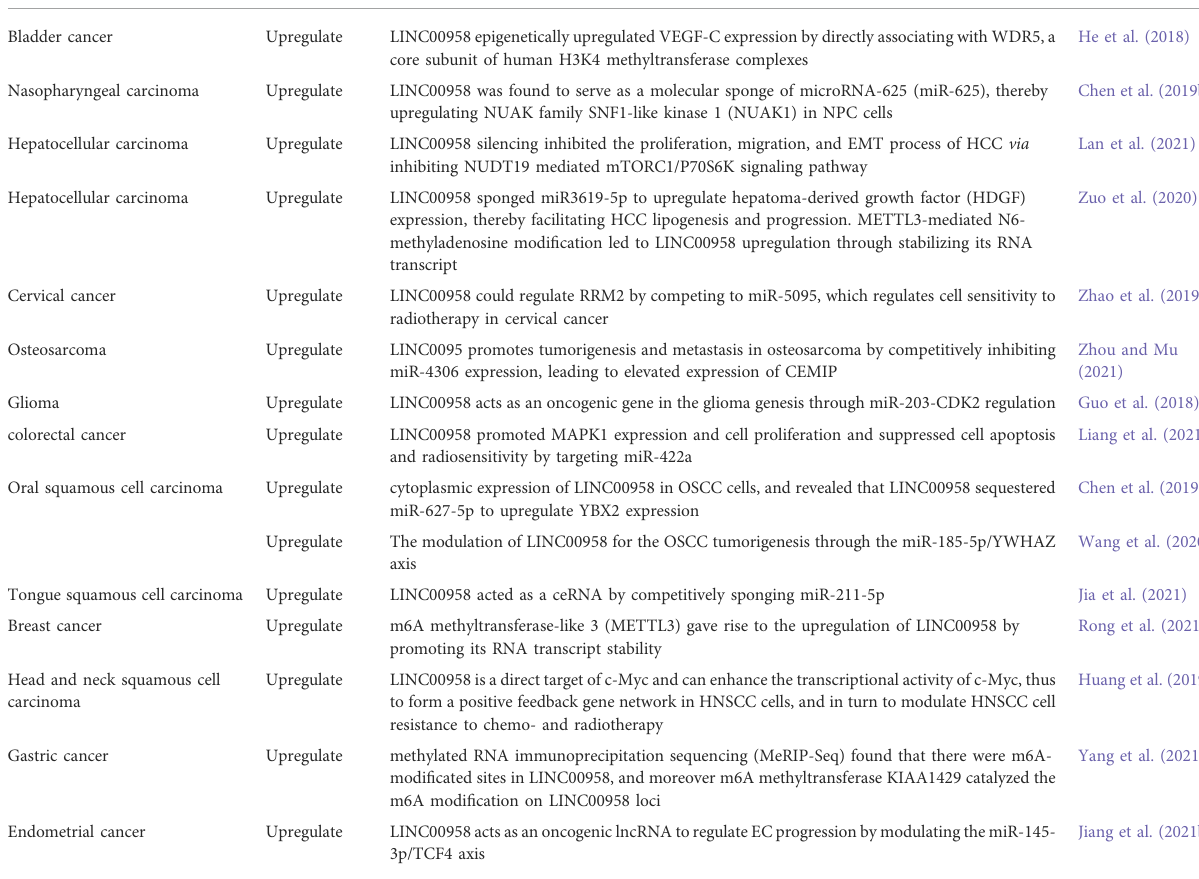
TABLE 5 Molecular mechanisms of LINC00958 oncogenesis in various